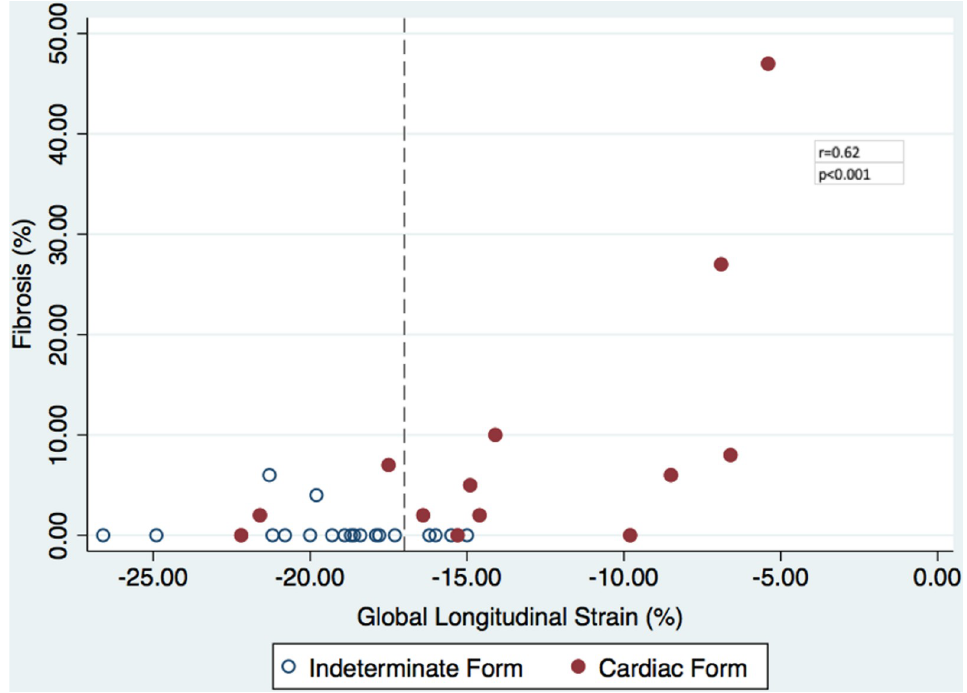
Fig 4. Correlation between myocardium percentage of fibrosis and GLS in patients with CD. Dotted line marks the clinical lower limit of normality of GLS for this software.